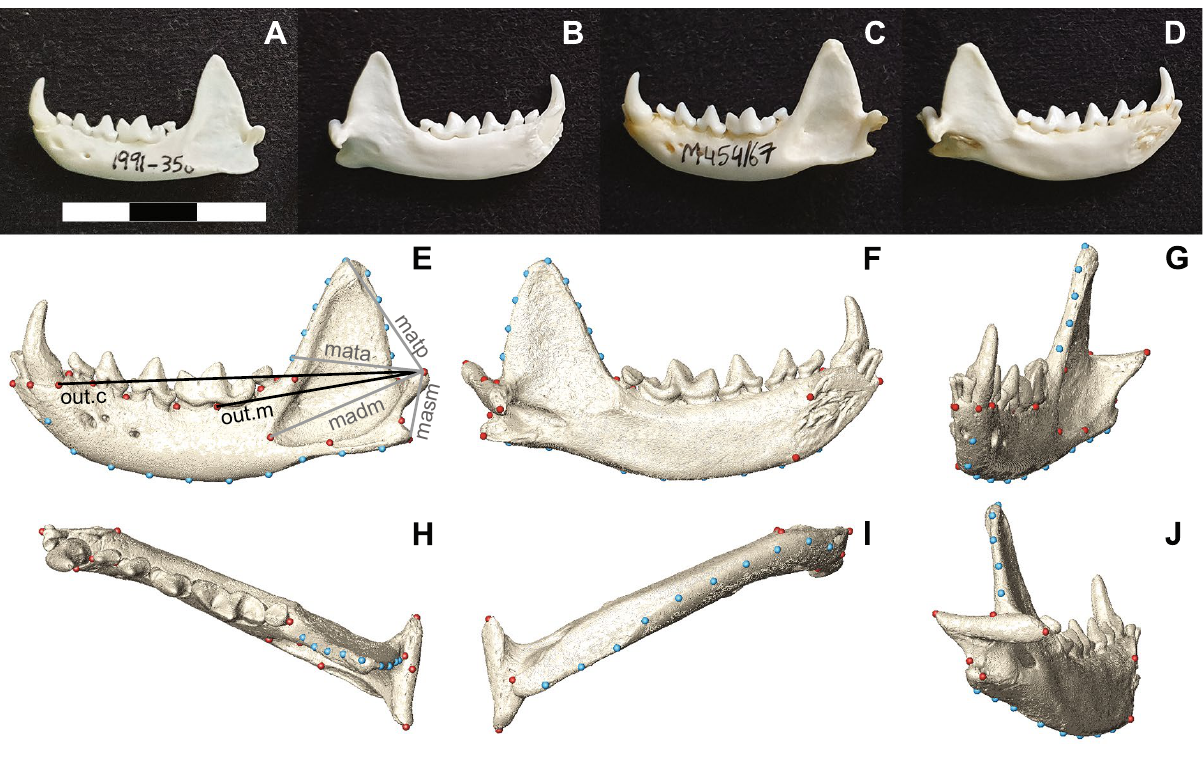
Figure 3. Mandible anatomy in minks ( A – D ) and landmark configuration used ( E – J ). European mink MNHN 1991–350 in lateral ( A ) and medial views ( B ). American mink NMS M454/67 in lateral ( C ) and medial views ( D ). Scale bar = 3 cm. See Table S3for additional information on both specimens. The landmark configuration is shown on the 3D mesh for the American mink above, in lateral ( E ), medial ( F ), cranial ( G ), dorsal ( H ), ventral ( I ), and caudal views ( J ). Red dots represent landmarks (as defined in Table 4), while blue dots represent semilandmarks along curves. Black lines in ( E ) represent the out-levers used in the biomechanical analyses, while grey lines represent the in-levers. Abbreviations: madm, lever arm of the deep masseter; masm, lever arm of the superficial masseter; mata, lever arm of the anterior temporalis; matp, lever arm of the posterior temporalis; out.c, out-lever at the canine; out.m, out-lever at the